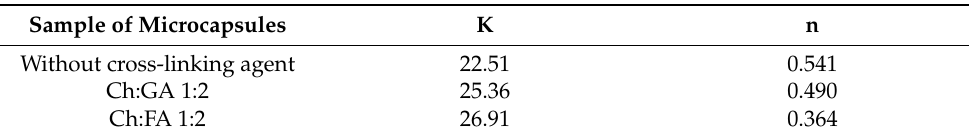
Table 6. Parameters of vitamin E release kinetics for the Korsmeyer-Peppas model (diffusion rate constant (K) and diffusion exponent